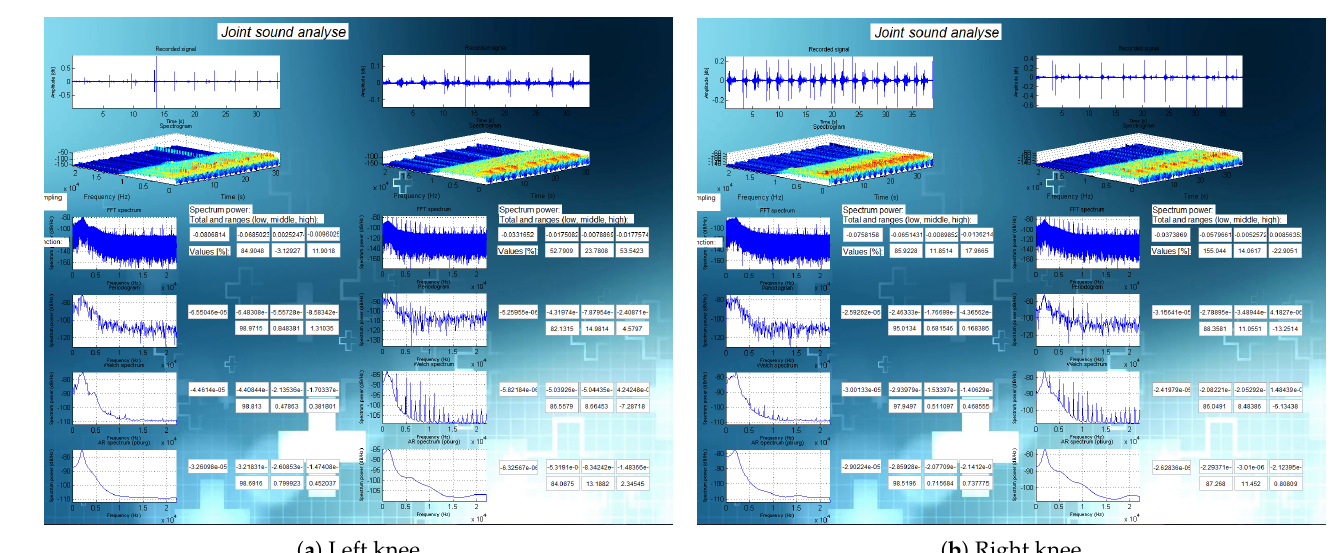
Figure A2. Analysis for subject 2.